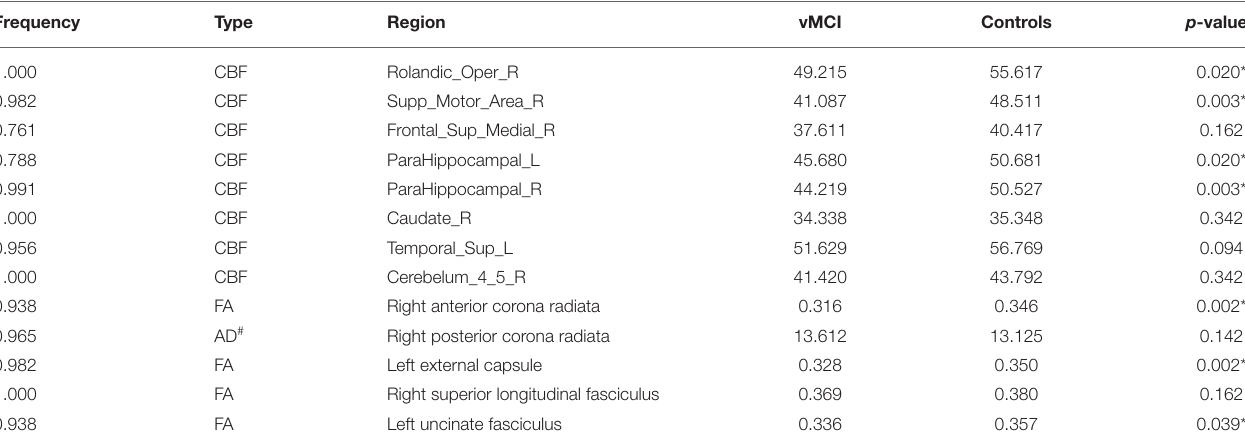
TABLE 3 | Identified combined diffusion/perfusion features for discriminating vMCI and Controls.